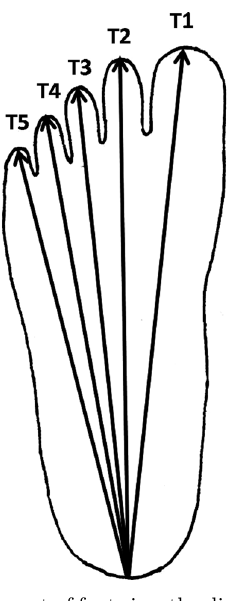
Figure 1. Measurement of foot size: the distal tip of toe to heel distance was marked on the paper and measured. The mean of the measurements T1 – T5 was taken as foot length. Distance between the outer margins of the fi rst and fi fth tarsometatarsal joints was measured as foot